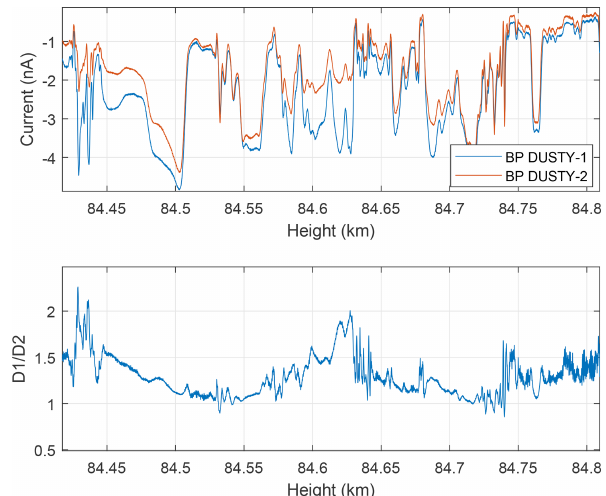
Figure 5. Magnification of the immediate region around the onset height ( ∼ 85 . 85km) of the large disagreement between the DUSTY probes. Above this height, the ratio of the two DUSTY currents becomes heavily modulated with a characteristic oscillation at the payload spin frequency.